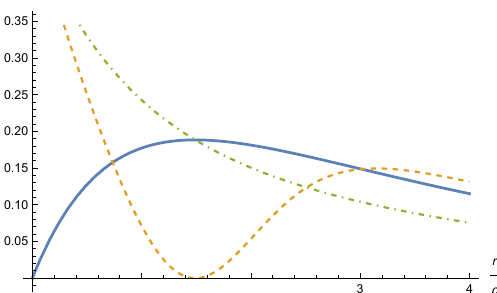
Figure 2 . The identical r -distributions for the ψ µ , λ − and ψ i zero modes of eq. (3.45) (blue, solid), the r -distribution for ξ − of eq. (3.112) (orange, dashed), and the r -distribution for λ + of eq. (3.120) (green, dash-dotted) in units of 1 . The mean values of r are about 4 . 2 ρ for the first, 4 . 4 ρ for the ρ second and 3 ρ for the